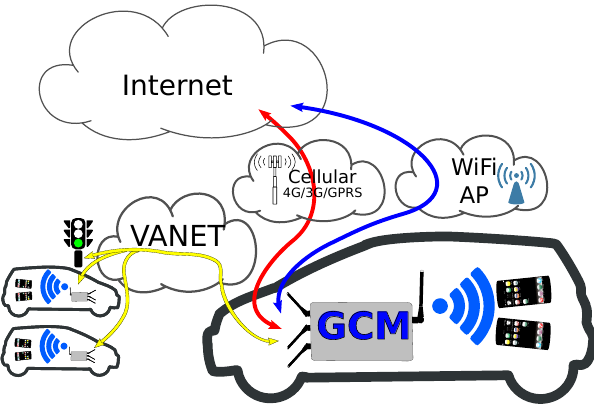
Figure 1: An example GCM connected to several net-